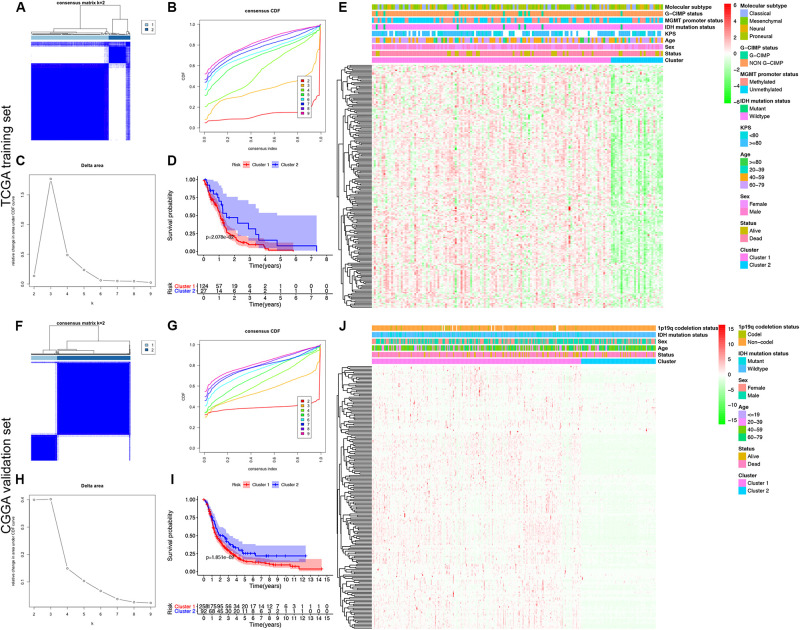
Identification and validation of an MDG-based molecular classification of GBM patients using the unsupervised consensus clustering algorithm. Consensus clustering matrix for k = 2, which was the optimal cluster number in both the TCGA training cohort (A) and CGGA validation cohort (F). Cumulative distribution function (CDF) curves of the consensus score (k = 2–9) in the TCGA (B) and CGGA cohorts (G). The relative change in the area under the CDF curve (k = 2–9) in the TCGA (C) and CGGA cohorts (H). Kaplan-Meier survival analyses of the patients in the Cluster 1 and Cluster 2 subgroups in the TCGA (D) and CGGA cohorts (I), which indicated that the patients in Cluster 1 had poorer OS than those in Cluster 2. The heatmap and clinicopathological features of the two clusters based on the expression patterns of the MDGs in the TCGA (E) and CGGA cohorts (J).